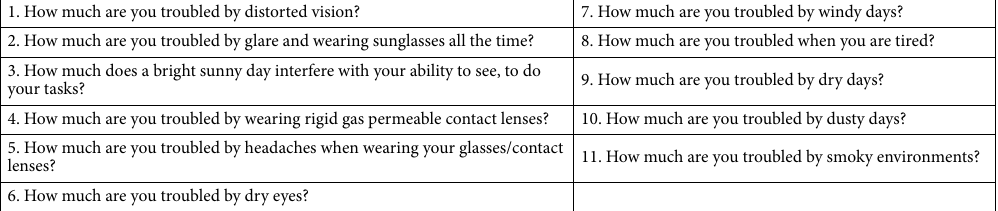
Table 2. KORQ questionnaire Part II—Symptoms. KORQ Keratoconus Oucomes Research